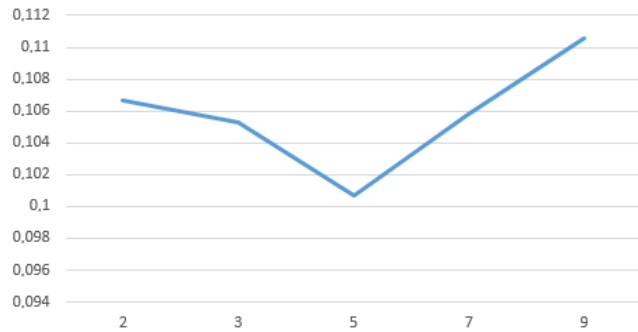
Figure 4. Relative Error (RE) representation for k-Nearest Neighbors (k-NN) during the optimization parameter process: values tested for k ( X -axis) and the obtained RE values ( Y